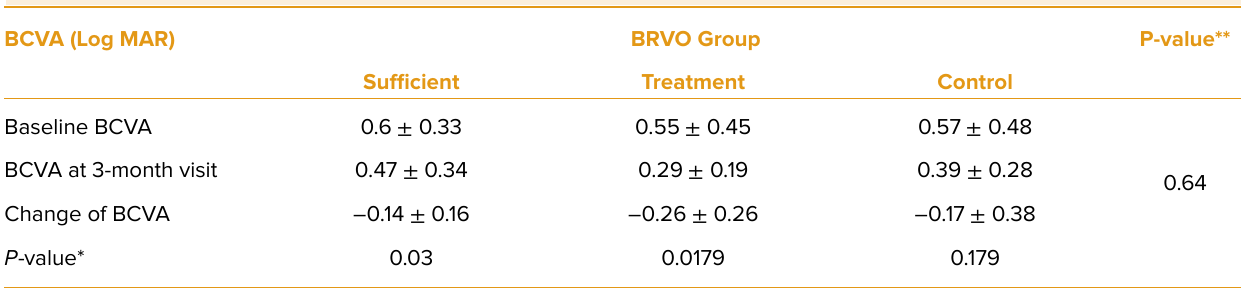
Table 4. The Changes of BCVA following three IVB injections in BRVO subgroups.